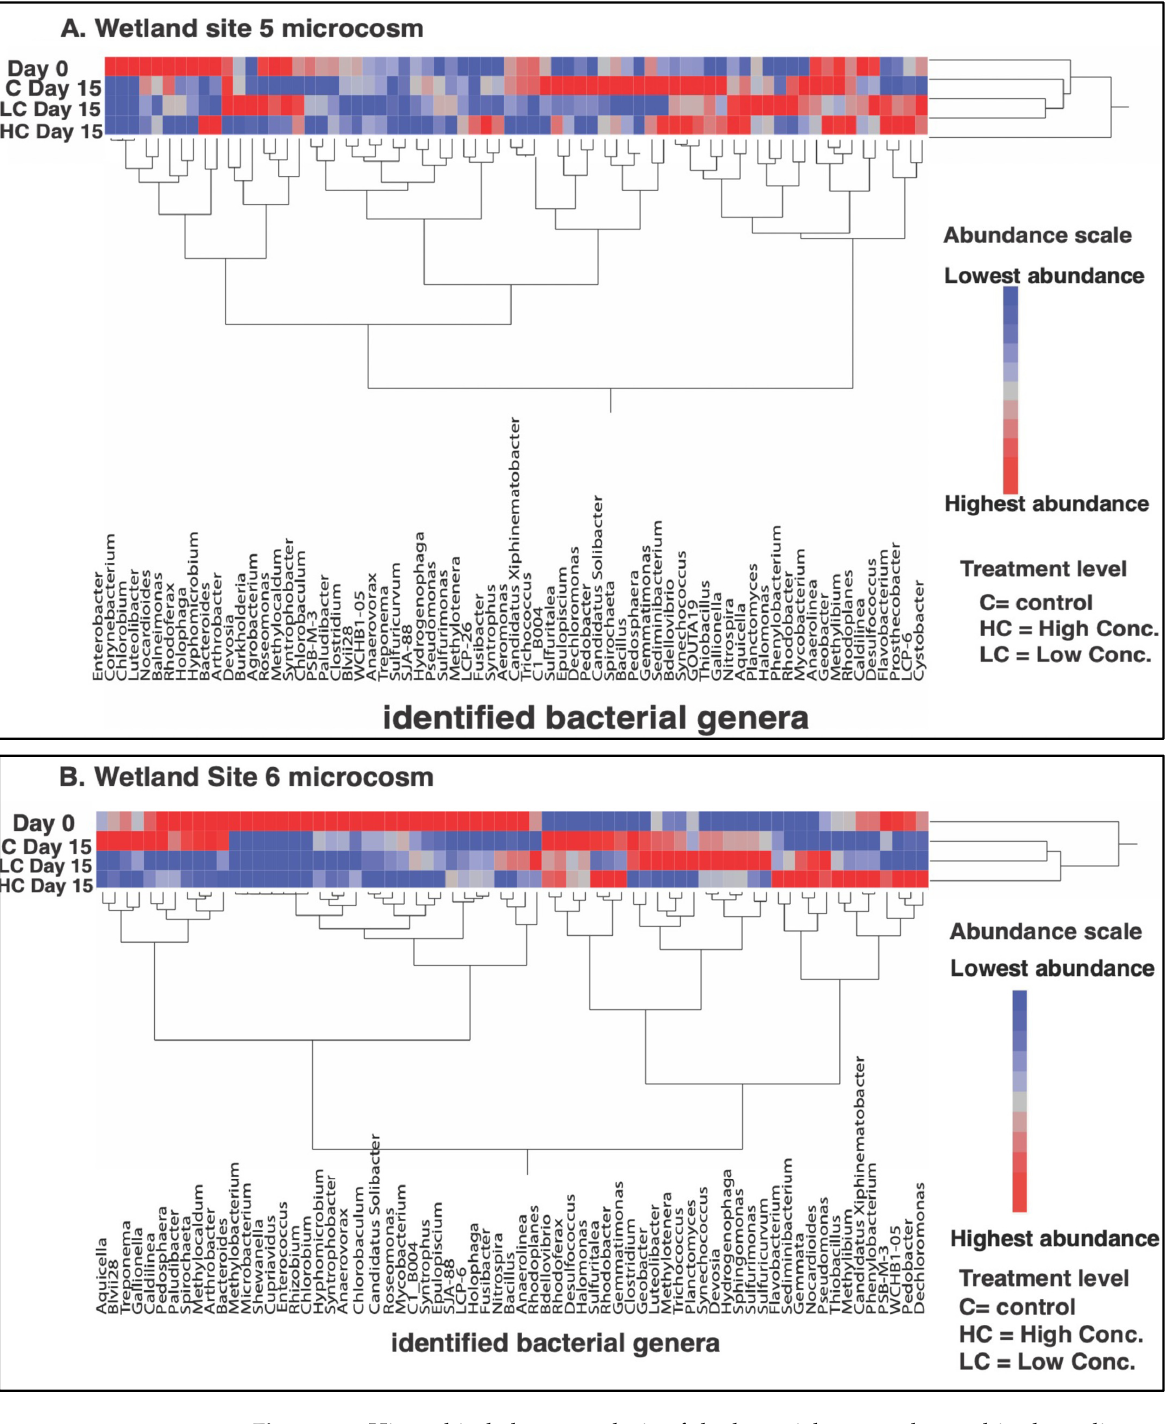
Figure 10. Hierarchical cluster analysis of the bacterial genera detected in the sediments of the treatments of wetland sites 3 ( A ) and 4 ( B ) metal microcosm, where day 0 = beginning treatment of the metal microcosm experiment; C Day 15 = treatment of the metal microcosm experiment of the native control sediment with no metals added; LC Day 15 = end treatment (day 15) of the metal microcosm experiment with metals (Pb and Cu) added in lower concentrations in the water to the sediment; HC Day 15 = end treatment (day 15) of the metal microcosm experiment with metals (Pb and Cu) added in higher concentrations in the water to the sediment, as illustrated in the experimental design under Table